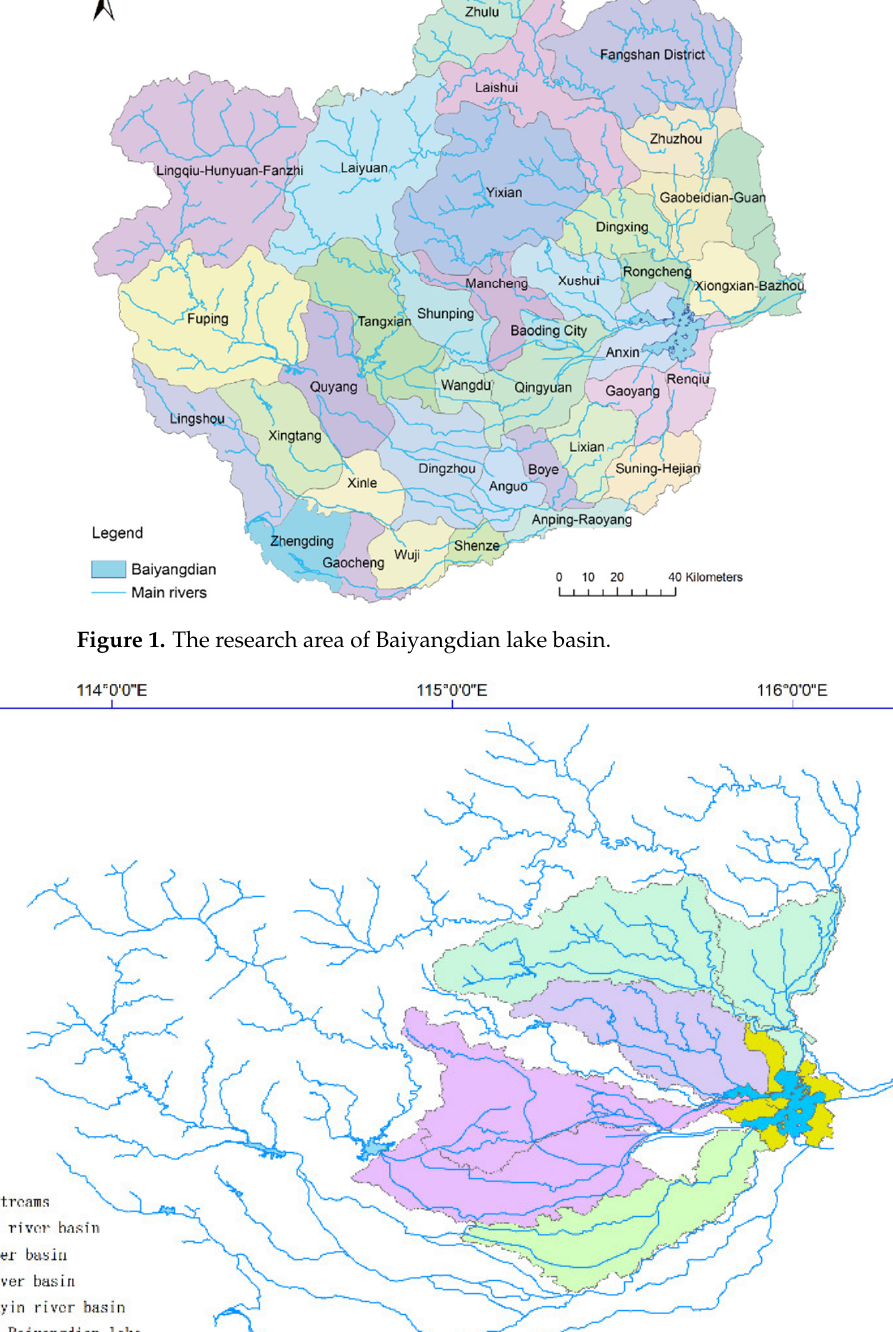
Figure 2. The sub-basin division of Baiyangdian lake basin.